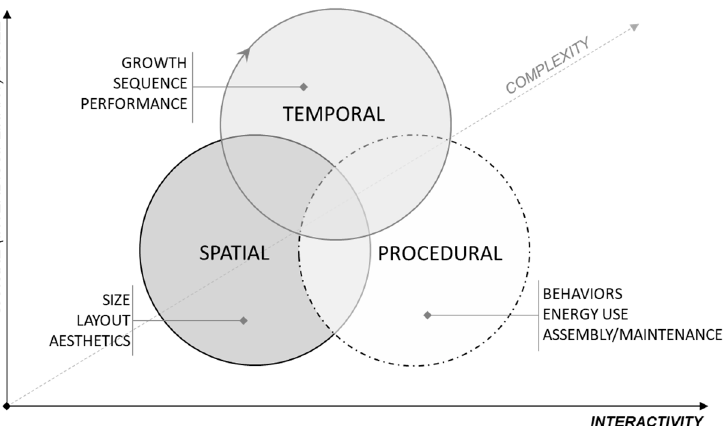
Figure 5. Conceptual representation of the VR experience development complexity as a factor of information type, scale, and levels of interactivity.